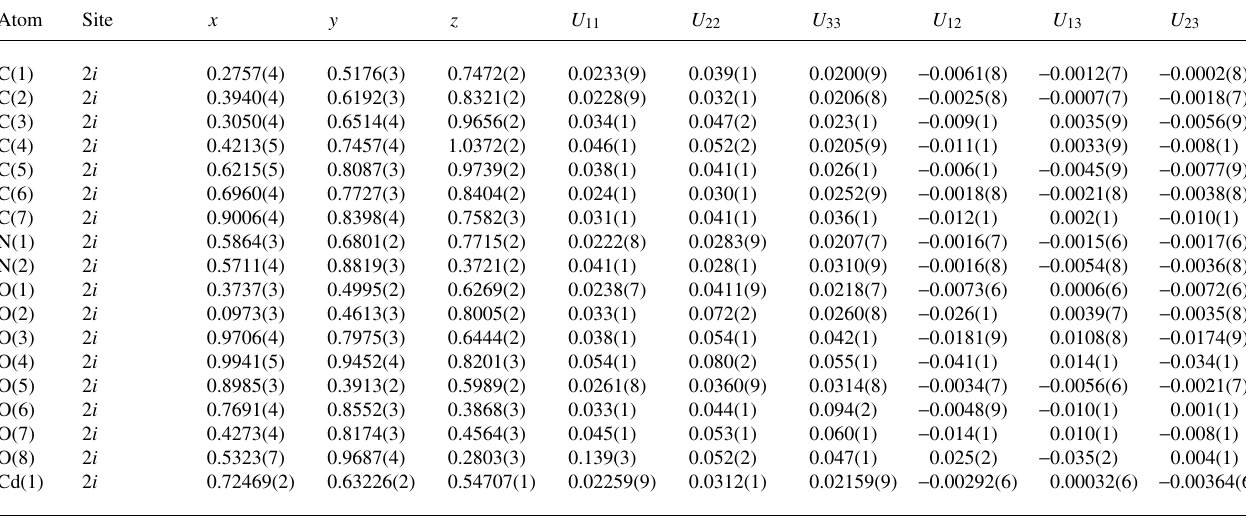
Table 3. Atomic coordinates and displacement parameters (in Å 2 ) .